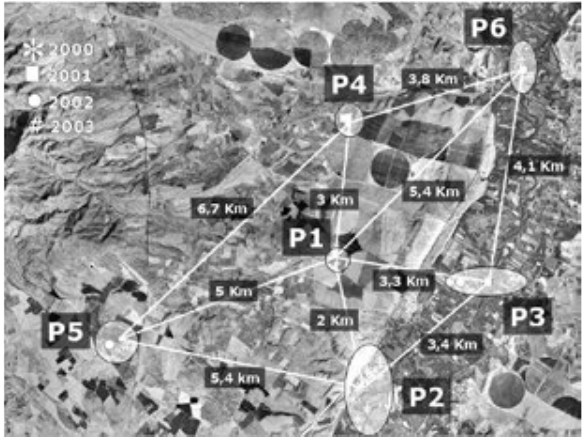
Figure 2. Location of the six areas where fire blight epi - sodes were detected in pome fruits in Zaragoza (Spain) between years 2000 to 2003. Distances among each area as well as affected orchards inside each area (indicated by symbols) are